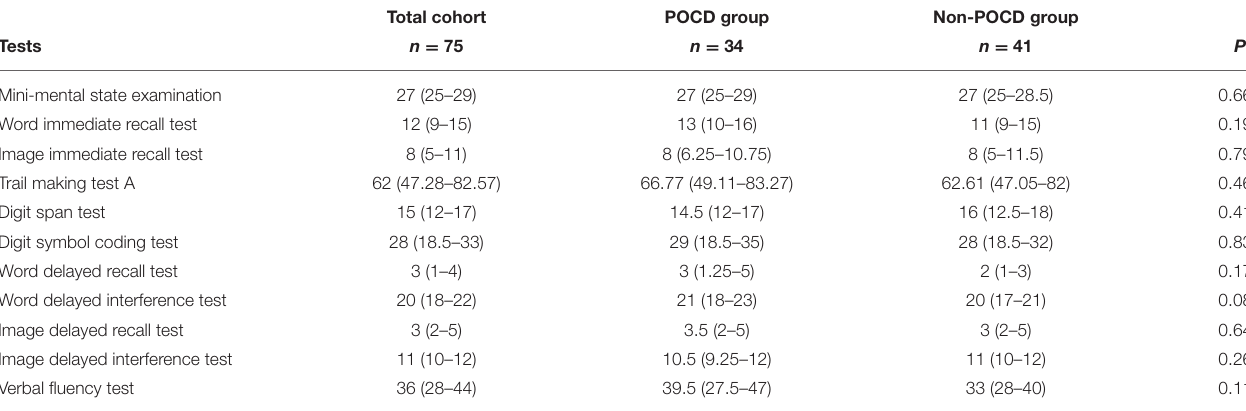
TABLE 2 | Preoperative cognitive functions of total cohort, POCD group, and non-POCD group.